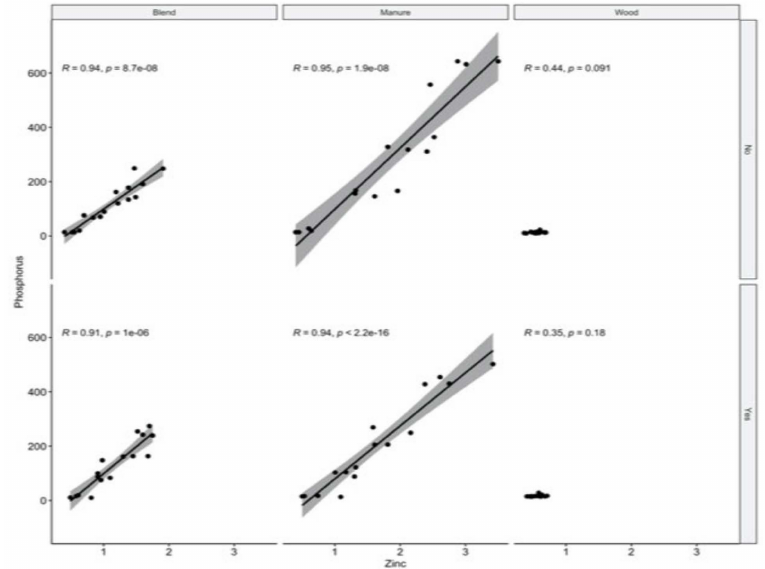
Figure 7. P (ppm) × Zn (ppm), Spearman’s correlation for Trifolium incarnatum soils by biochar type and saturation (yes is